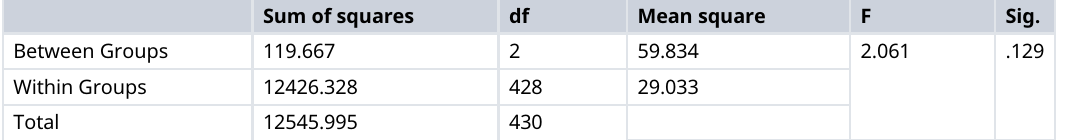
Table 1. One way ANOVA test for type of dental practice and response by the study participants. Sum of squares df F